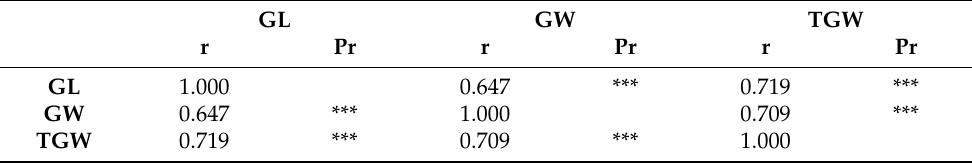
Table 3. Correlation analysis of GL, GW, and TGW in the BC 9 F 3 population.